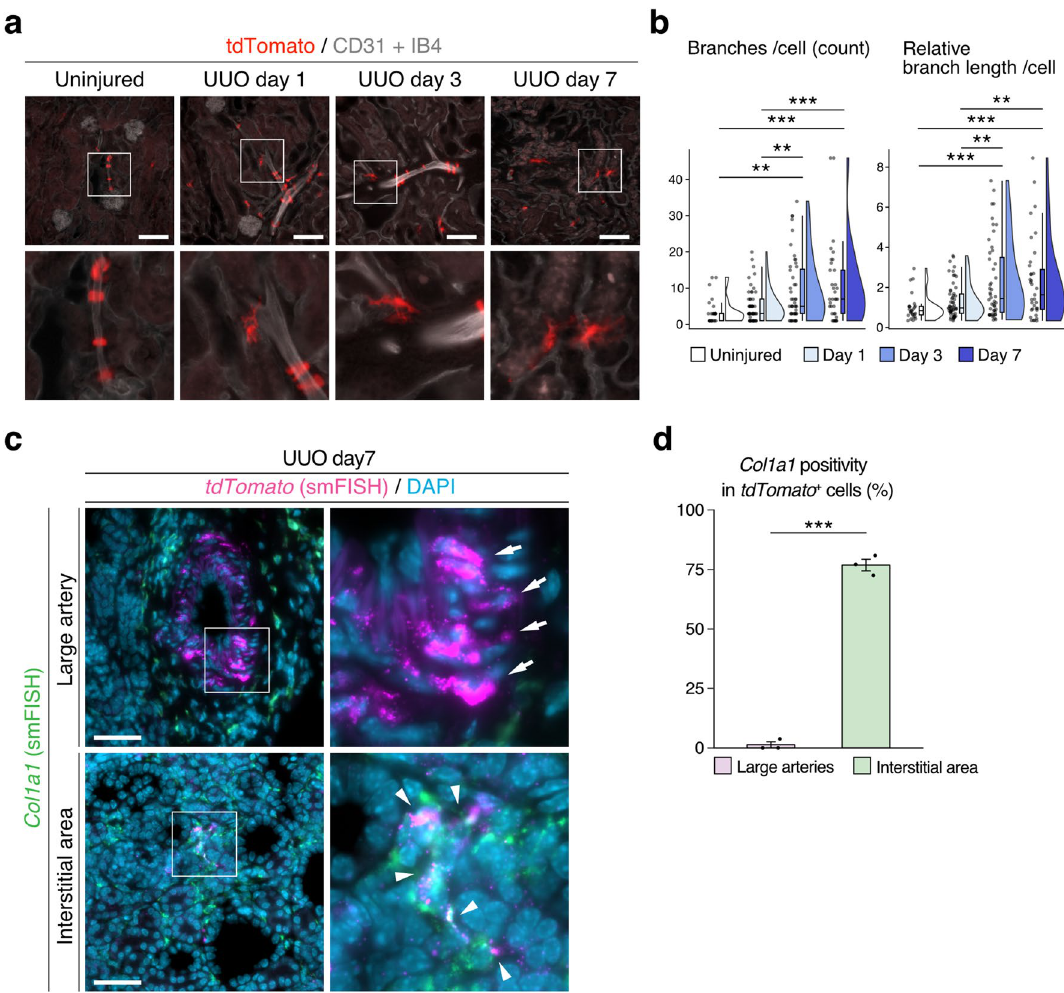
Figure 7. Meflin + PMCs detach from the vasculature and produce collagen during renal fibrosis. ( a,b ) Meflin- CreER T2 ; LSL-tdTomato mice were subjected to UUO surgery 14 days after TAM-administration, followed by staining of uninjured and UUO kidneys for CD31 and IB4 to visualize the vasculature (white). Note that tdTomato + cells surrounding the vasculature in uninjured kidneys were detached from the vasculature in UUO kidneys ( a ). Quantification of morphological changes (branching and branch length) of tdTomato + cells (total 167 cells) over time after UUO surgery ( b ). ( c,d ) smFISH analysis for tdTomato and Col1a1 (UUO day 7). Although tdTomato + cells surrounding the vasculature do not express Col1a1 , tdTomato + cells detached from the vasculature in interstitial area express Col1a1 ( c ). Shown in ( d ) is the quantification of Col1a1 positivity in tdTomato + cells. For each group, 3 or 4 cross-section (400×) of the vasculature per sample and 5 sections of the interstitial area (400×) per sample obtained from three kidneys were evaluated. ** p < 0.01, *** p < 0.001 [one-way ANOVA followed by Tukey’s multiple comparisons test ( b ); unpaired t -test with Welch’s correction ( d )] Boxed areas were magnified in adjacent panels. Scale bars, 100 ( a ) and 50 ( c ) µm. Data were analyzed and visualized using R software 47 in ( b,d